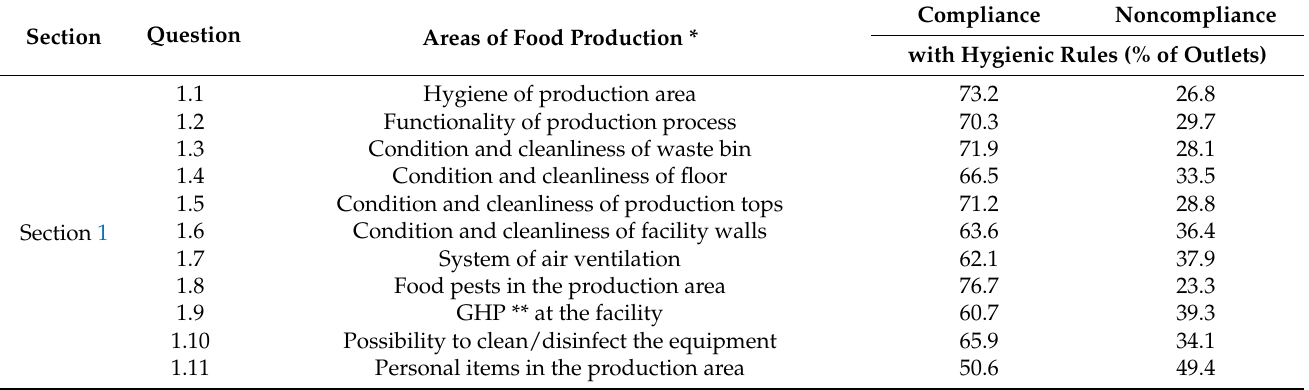
Table 1. Sanitary conditions and hygiene of food production and distribution in street food outlets ( n = 550).